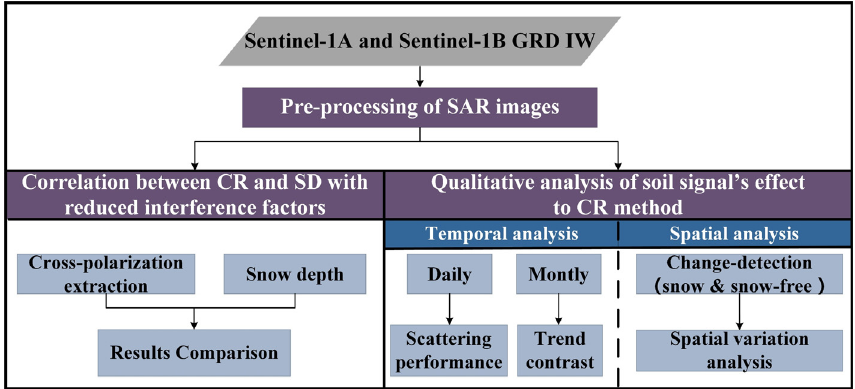
Figure 2. Overall workflow for exploring the backscattering properties of feature areas under snow cover using Sentinel-1 data in GEE.